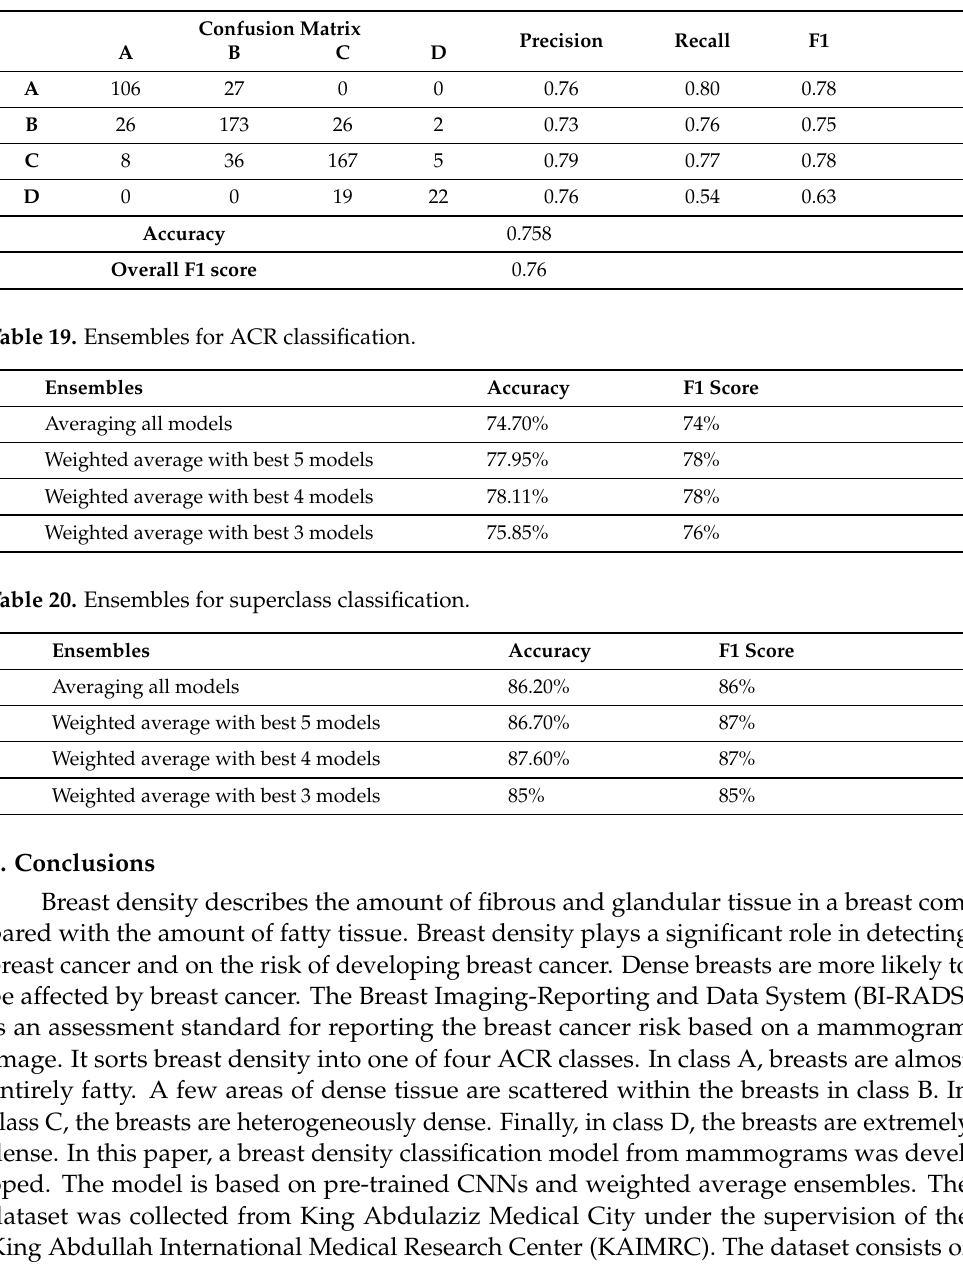
Table 18. Weighted average ensembles with best 3 models.